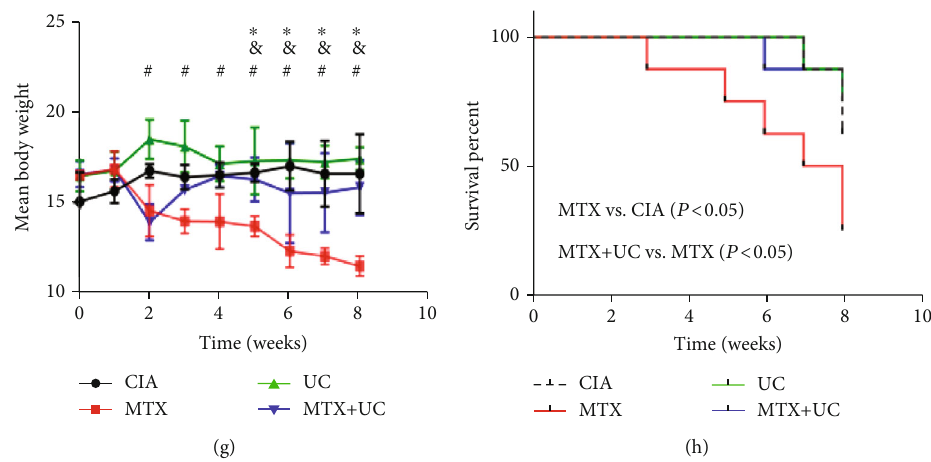
Figure 1: Combined use of UCs and MTX enhanced the therapeutic e ffi cacy of MTX. (a) The therapeutic design of the CIA mice. (b, c) Combined use of MTX and UCs showed the mildest paw swelling and bone erosion. (d) H&E staining showed that the MTX+UC group had the best e ff ect on suppressing synovitis, erosion, and in fl ammatory cell in fi ltration compared to the other three groups. (e) Mean arthritis score of four groups was evaluated every week. ∗ P < 0 : 05 , MTX vs. CIA; & P < 0 : 05 , UC vs. CIA; # P < 0 : 05 , MTX+UC vs. CIA. (f) Histological score evaluation in four groups. ∗ P < 0 : 05 ; ∗∗∗ P < 0 : 001 ; ns: no signi fi cance ( P > 0 : 05 ). (g) Combination of MTX and UCs protected CIA mice from severe weight loss caused by MTX. ∗ P < 0 : 05 , MTX vs. CIA; & P < 0 : 05 , MTX+UC vs. MTX; # P < 0 : 05 , UC vs. MTX. (h) Combination of MTX and UCs prolonged the lifespan of the mice treated by MTX. Scale bar, 250 μ m. n = 3 ‐ 10 per group. Data are shown as mean ± SD